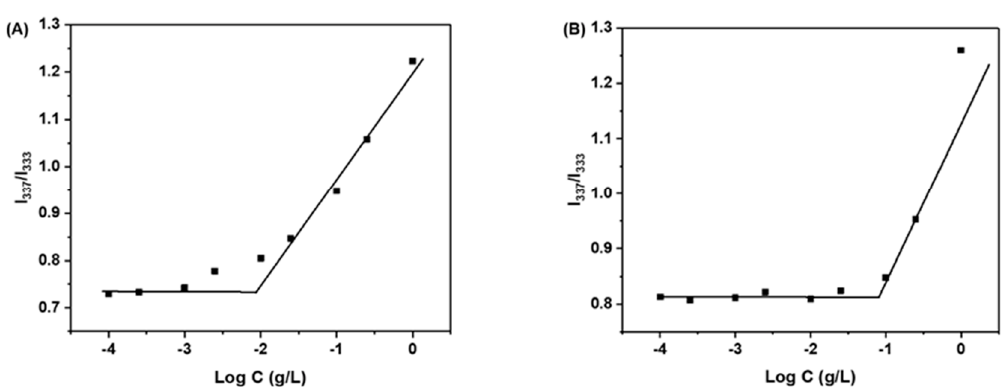
Figure 2. Plot of the intensity ratio I 337 /I 333 from the pyrene excitation spectra versus the logarithm of gemini mPEG-Cys-PMT ( A ) and oxidized gemini mPEG-Cys-PMT treated with 0.1 mM H 2 O 2 for 12 h ( B ).